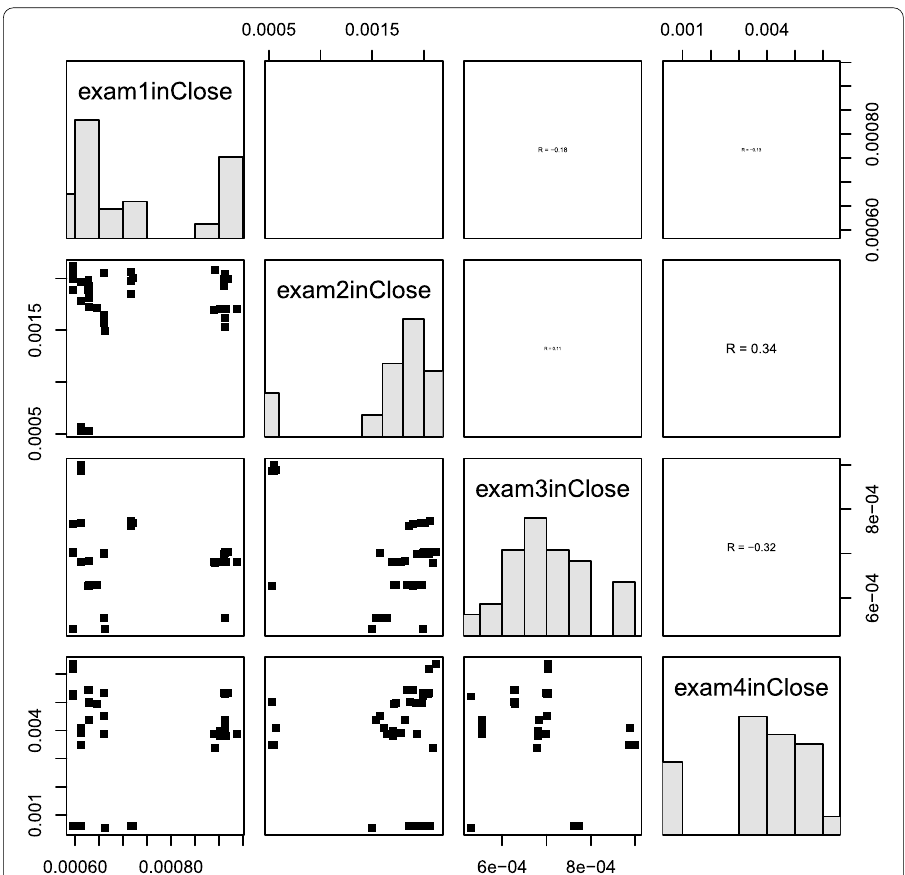
Fig. 7 In-closeness centrality distributions, scatterplots, and Spearman correlation coefficients for the Fall 2015